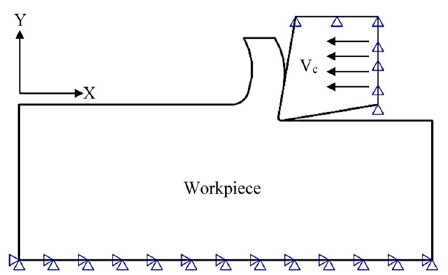
Figure 4. Boundary conditions for the workpiece and the cutting tool models. Table 4. Boundary conditions for the modelling of the workpiece and the cutting tool. Boundary Condition Workpiece Cutting Tool